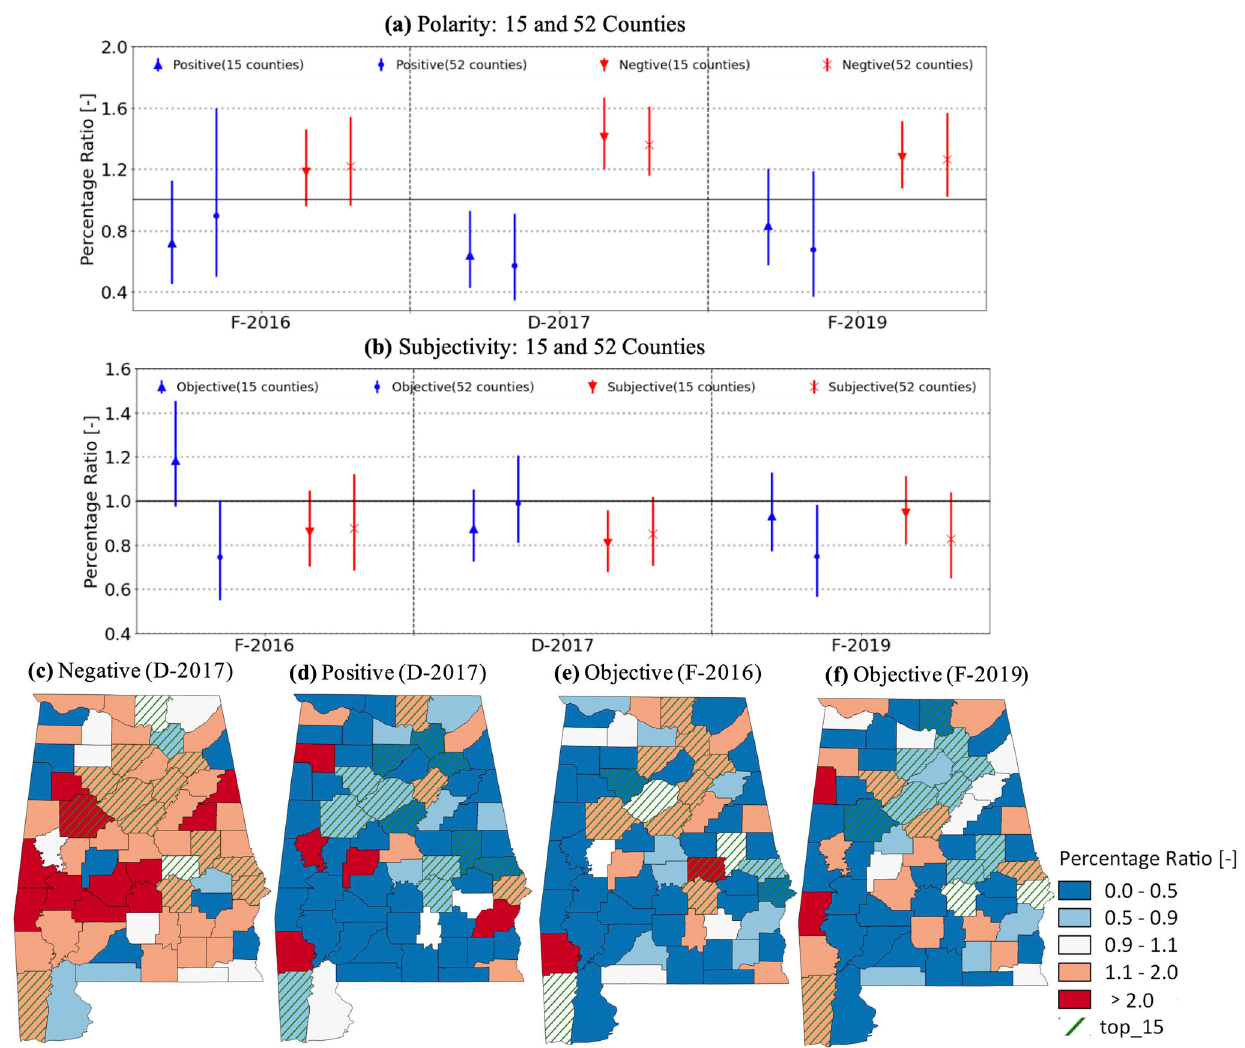
Fig. 3 Altered sentiment of water pollution complaints during historical climatic extremes. Triangles and downward triangles (circles and cross markers) in ( a ) depict the percentage ratios of positive and negative complaints, respectively, based on polarity scores to the state-level percentages for the top 15 (other 52) counties (other 52 counties). Triangles and downward triangles (circles and cross markers) in ( b ) depict the percentage ratios of objective and subjective complaints, respectively, based on subjectivity scores to the state-level percentages for the top 15 (other 52) counties. Error bars depict the 95th percentile ranges of the percentage ratios from 10,000 bootstrapped samples. County- level maps in ( c ) and ( d ) depict the percentage ratios of negative and positive complaints, respectively, during D-2017. County-level maps in ( e ) and ( f ) depict the percentage ratios of objective complaints during F-2016 and F-2019,